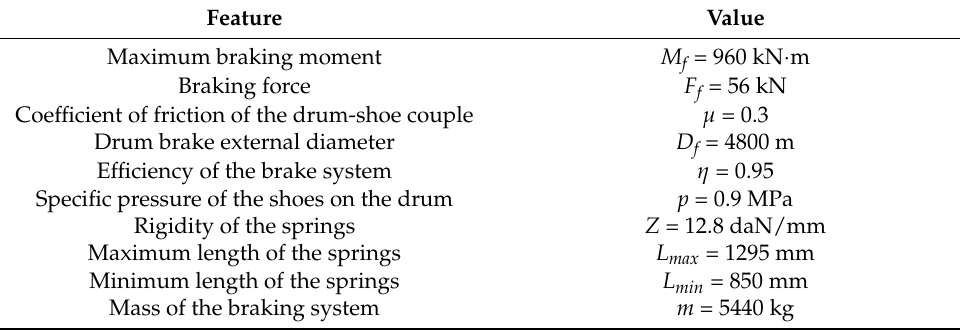
Table 1. Features of the MK5 × 2 mine hoist brake system. Feature Value Maximum braking moment M f = 960 kN · m Braking force F f = 56 kN Coefficient of friction of the drum-shoe couple µ = 0.3 Drum brake external diameter D f = 4800 m Efficiency of the brake system η = 0.95 Specific pressure of the shoes on the drum p = 0.9 MPa Rigidity of the springs Z = 12.8 daN/mm Maximum length of the springs L max = 1295 mm Minimum length of the springs L min = 850 mm Mass of the braking system m = 5440